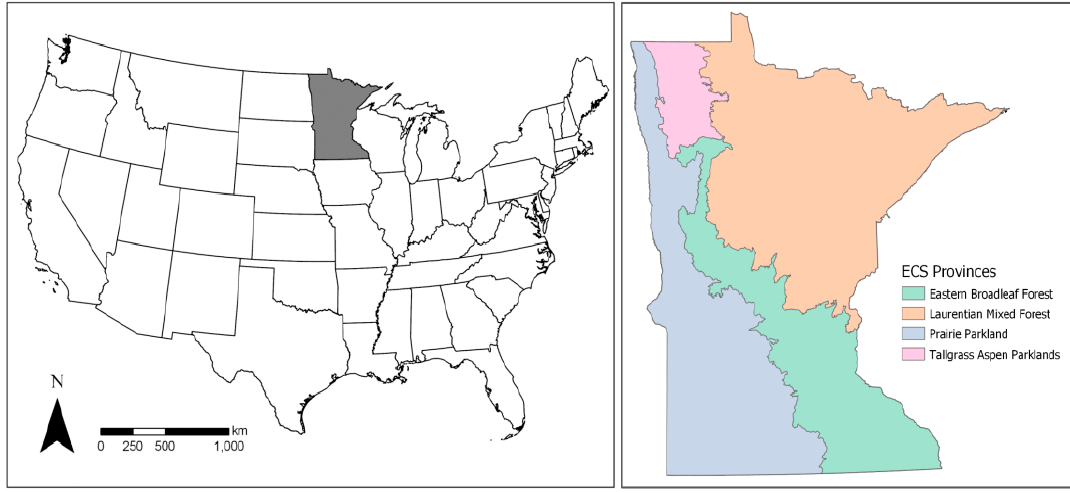
Figure 1. Minnesota’s location within the United States ( left ), and Ecological Classification System (ECS) provinces of Minnesota ( right ). Table 1. Information on invasive plant species included in this study.